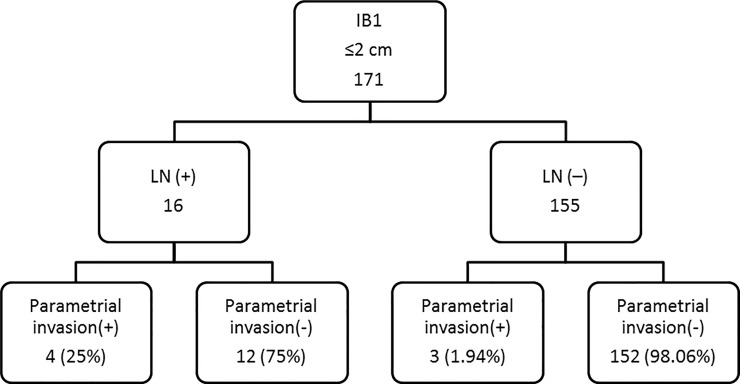
Scenario one to determine the need for parametrectomy during hysterectomy, according to the status of pelvic lymph node metastasis.